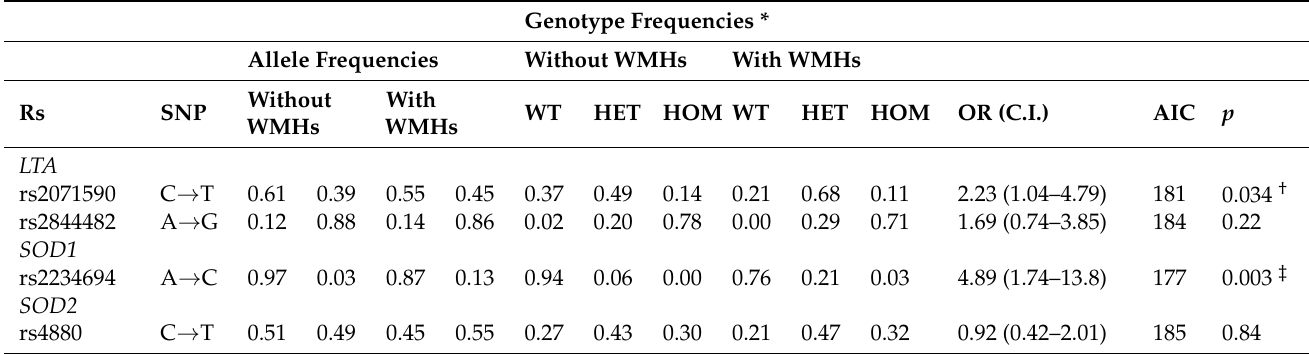
Table 4. Lymphotoxin alpha ( LTA ) and superoxide dismutase 1 ( SOD1 ) and 2 ( SOD2 ) genetic polymor- phisms and corresponding genotype frequencies in 172 migraine patients with (n = 38) or without (n = 134) white matter hyperintensities (WMHs).